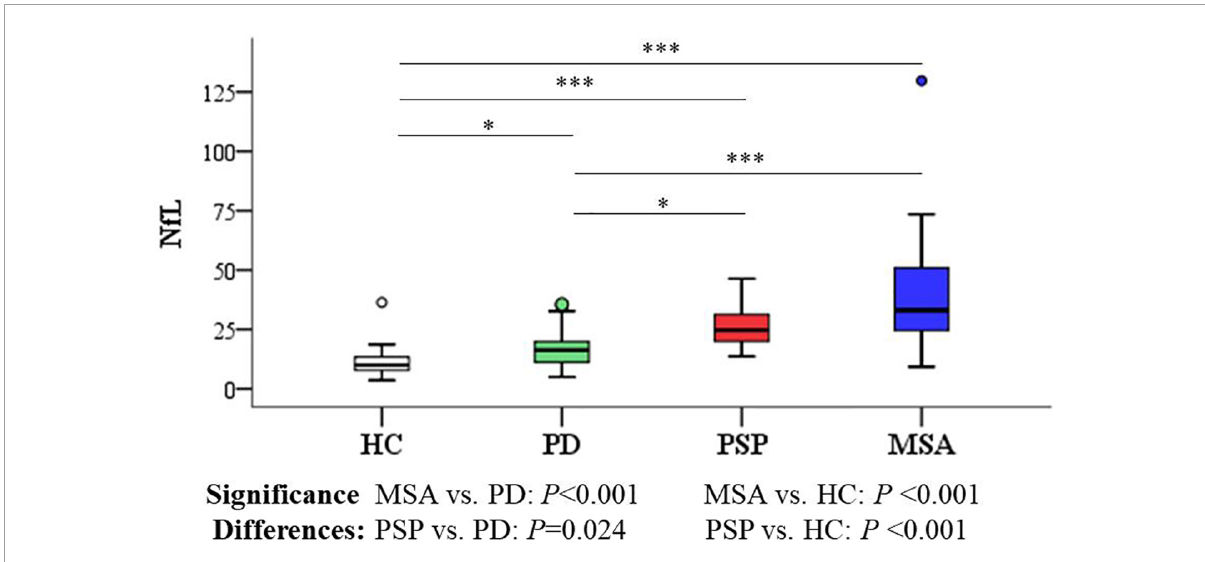
FIGURE4 Group comparisons of plasma NfL between parkinsonian disorders and HC. The P -values are corrected for multiple comparisons. ∗ P < 0.05, ∗∗∗ P ≤ 0.001. HC, healthy control; PD, Parkinson’s disease; PSP, progressive supranuclear palsy; MSA, multiple system atrophy.